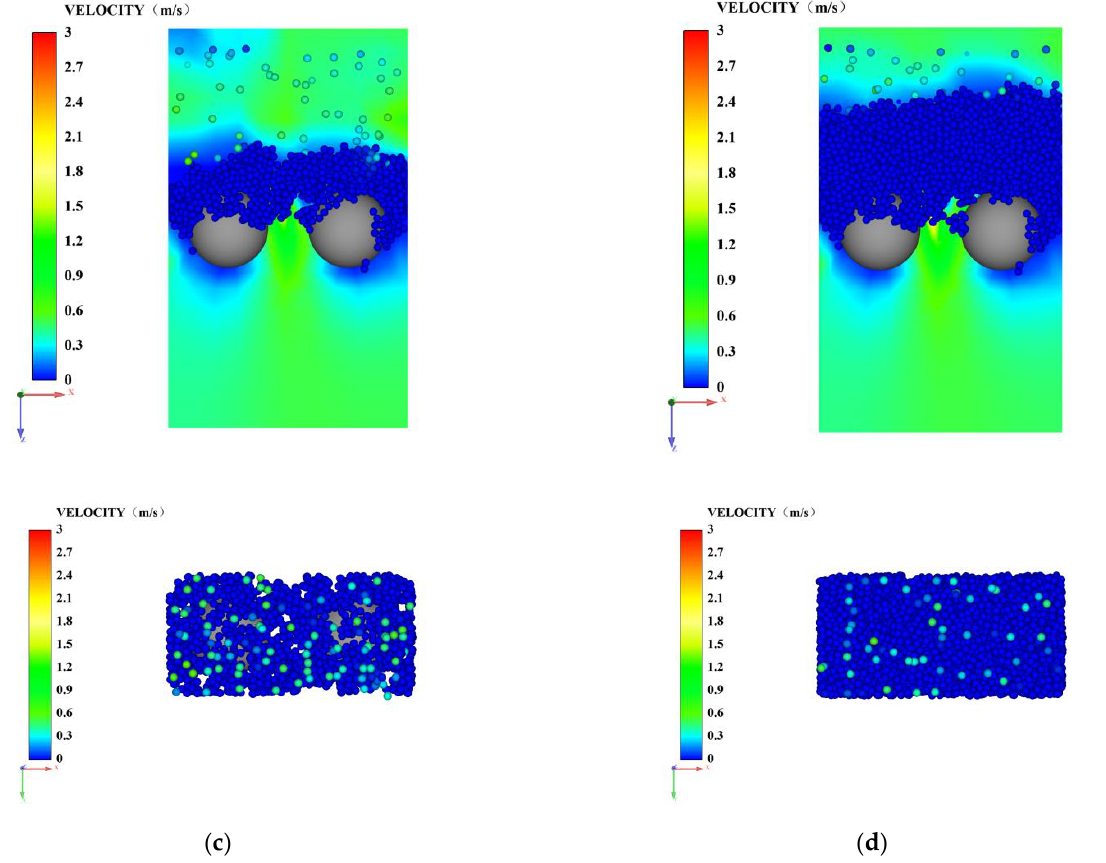
Figure 4. Bridging process. ( a ) A( ∆p = 29.3 Pa ); ( b ) B( ∆p = 59.9 Pa ); ( c ) C( ∆p = 928.4 Pa ); ( d ) D( ∆p = 6182.2 Pa ).